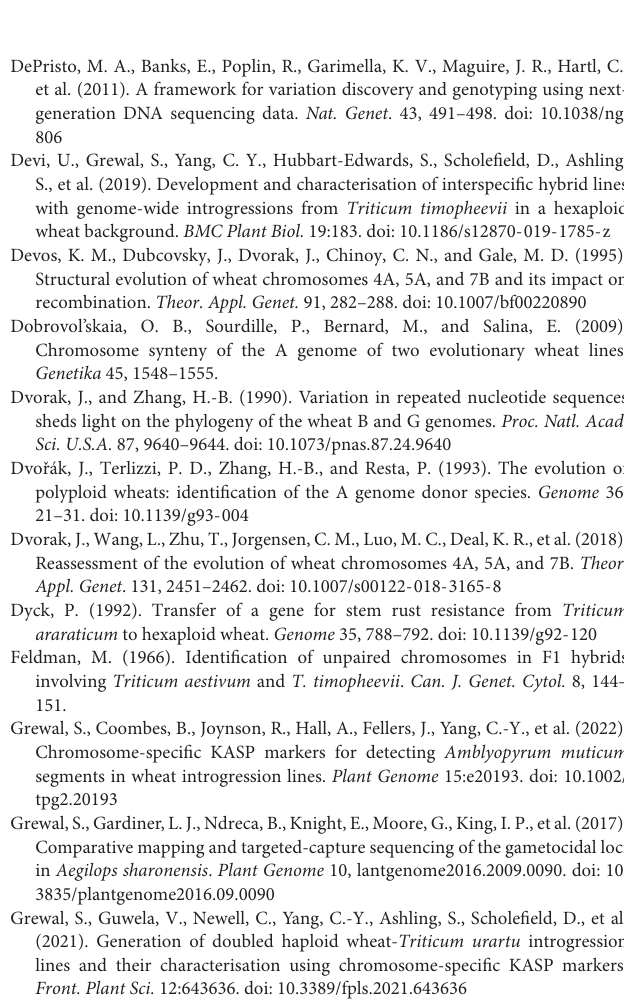
Supplementary Table 2 | Full set of validated chromosome-specific KASP markers that are detect subgenomes of Triticum timopheevii in a wheat